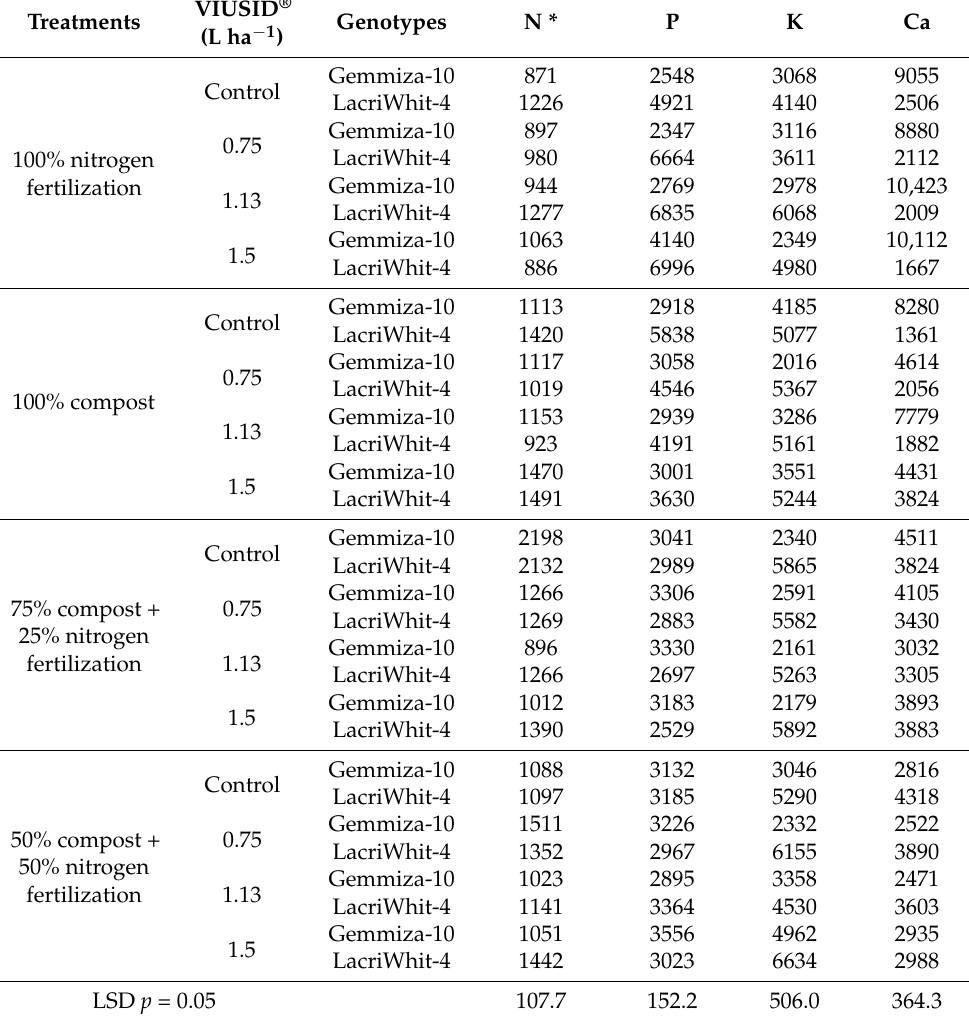
Table 8. Effect of different levels of compost, foliar application of VIUSID ® agro and two wheat cultivars on macronutrient contents of grain